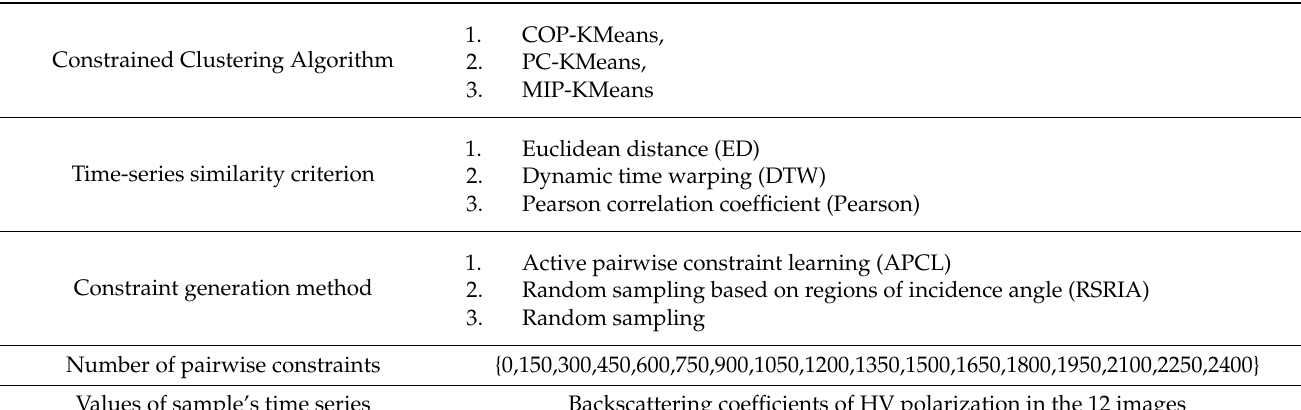
Table 3. Experimental settings of each group of